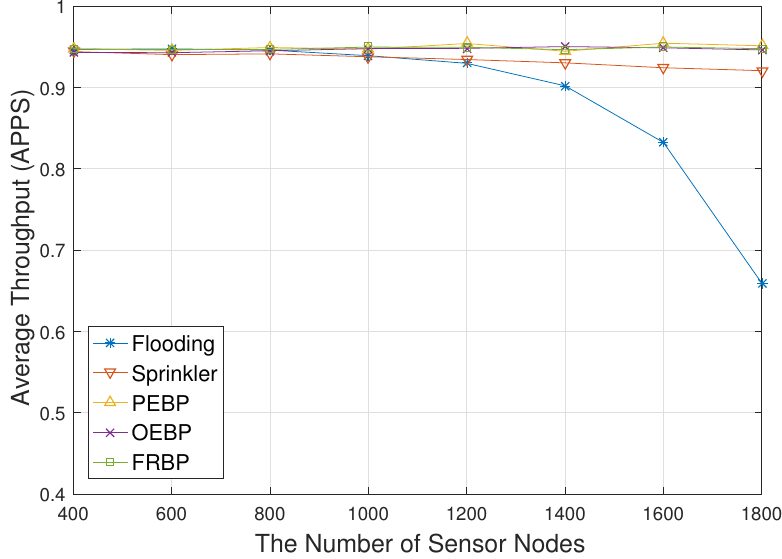
Figure 5. Average throughput impacted by the number of nodes.